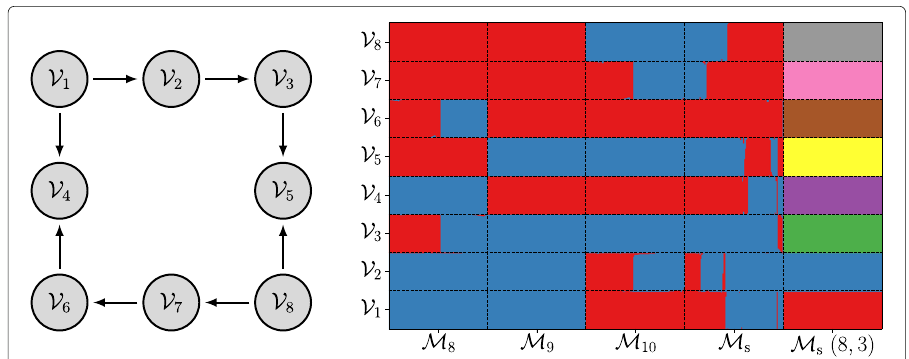
Fig. 7 Left : Diagram of the block structure for Example 2 Experiment 2: edges in the diagram are present with probability 0.5, all other edges are present with probability 0.0001 (including edges within blocks). Right : The detected groups found by each method, with k = 2 and l = 2, with the exception of the last column which has k = 8, l = 3. We test 100 replicates and present the results as columns in the plot. The nodes are ordered by block, and colors represent the group allocations in a given block for each motif-based method. We order replicates (i.e. columns) within each motif to highlight similarities, the columns are sorted within block in order to promote contiguity of the colors across each block. While the clustering assignments may contain some errors, the results are relatively robust across